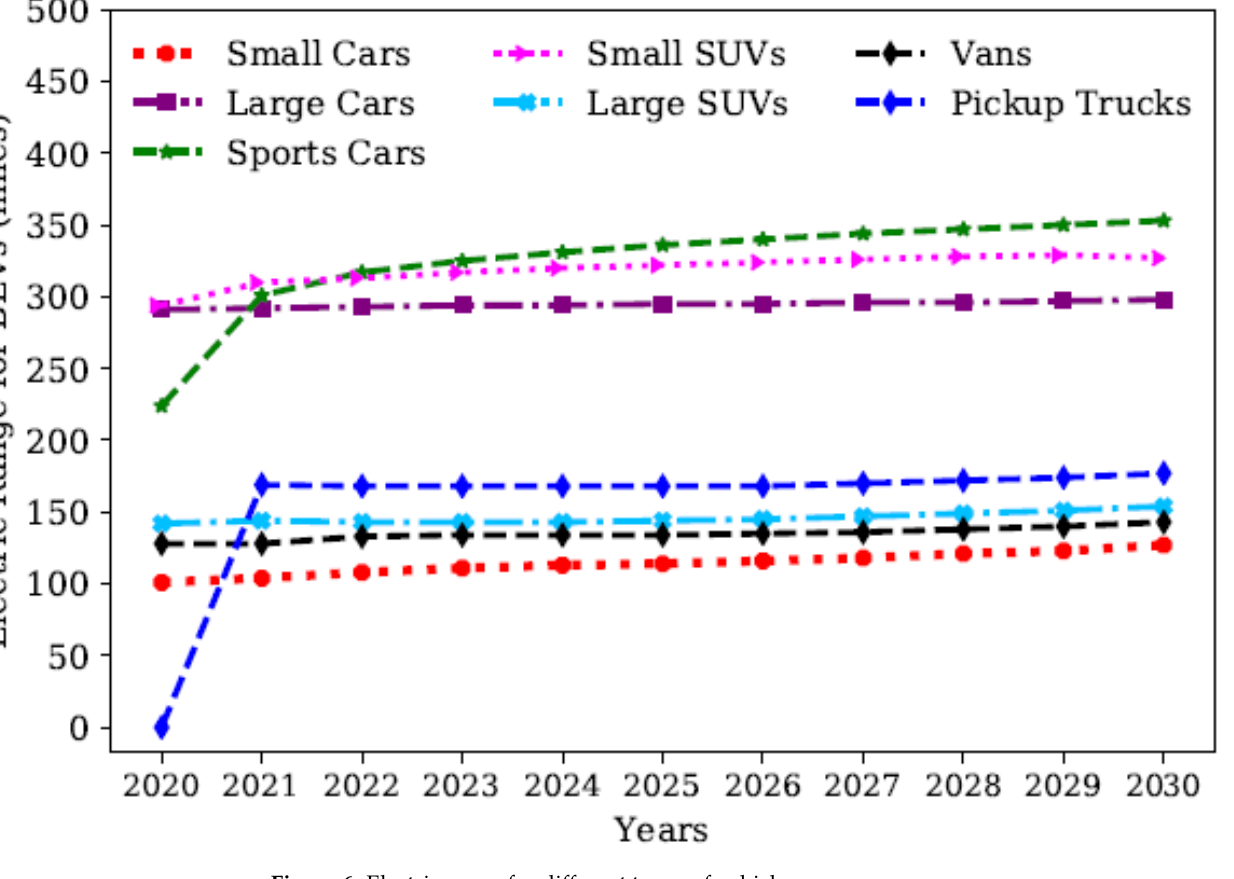
Figure 6. Electric range for different types of vehicles.